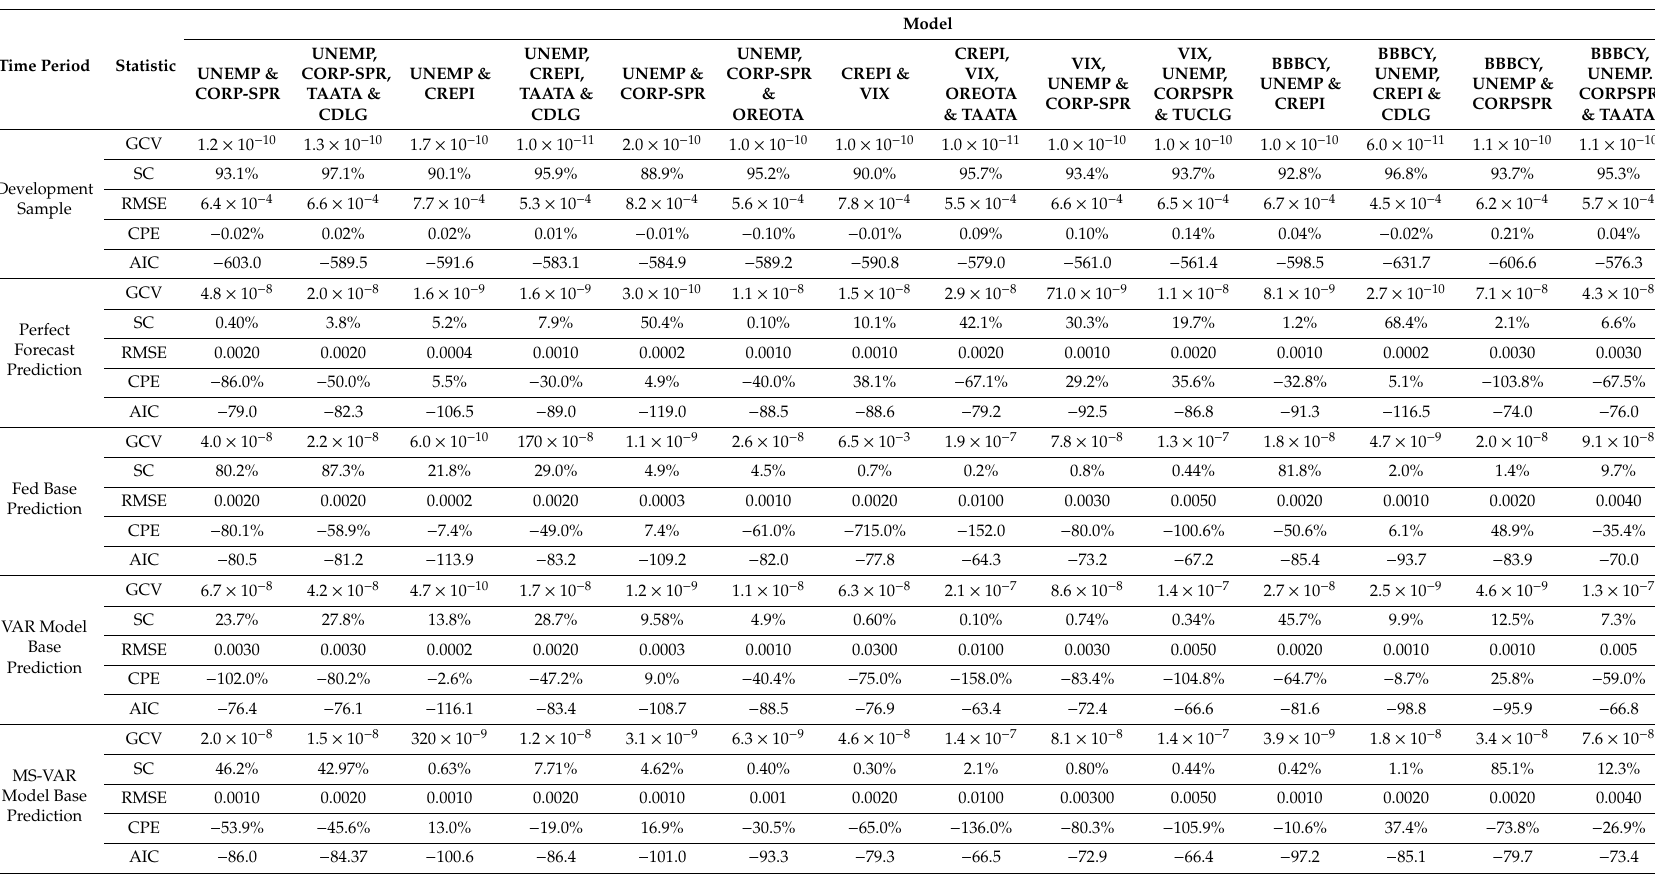
Table 4. CECL vector autoregressive model of in- and out-of-sample performance measures compared—historical Y9 credit loss rates, banking system idiosyncratic, and macroeconomic variables (FDIC SDI Report, Federal Reserve Board 4Q91–4Q15 and Jacobs (2018)